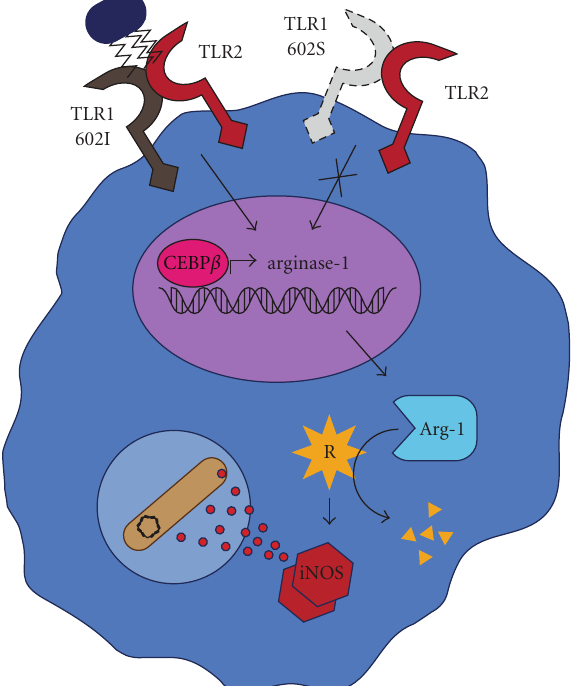
Figure 2: Arginine (R) is required as a substrate for inducible nitric oxide synthase (iNOS) in the production of nitric oxide. Nitric oxide contributes to microbial killing by combining with reactive oxygen intermediates in the phagolysosome to produce highly toxic peroxynitrite. Activation of surface TLR2 and TLR1 602I by mycobacterial products, including the 19 kDa lipoprotein, induces transcription of arginase-1 in a CEBP β -dependent manner. Arginase-1 reduces substrate availability for iNOS by breaking down arginine, reducing the production of reactive oxygen species and favoring mycobacterial survival. TLR1 602S does not tra ffi c to the cell surface (dashed lines) and therefore does not form a TLR1/2 signaling complex which would normally dampen the oxidative